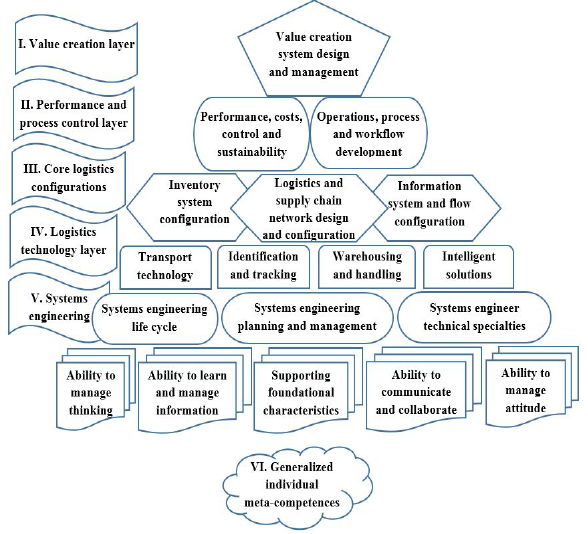
Figure 2. The building blocks of logistics systems engineer’s